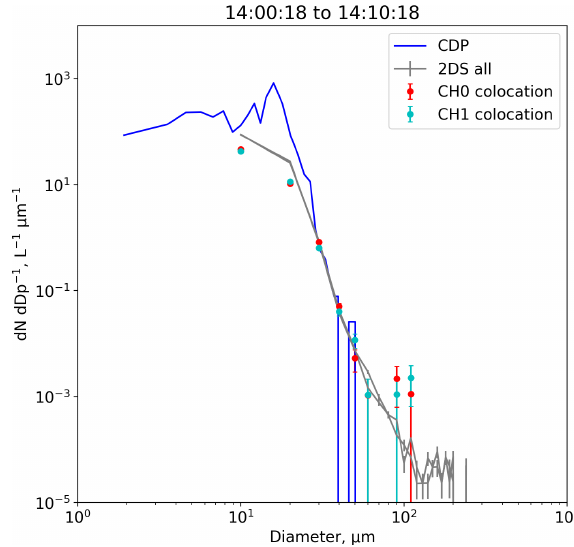
Figure 16. Size distributions from the 2D-S and CDP for different temperatures during a research flight in liquid stratus on 17 Au- gust 2018 at 13 ◦ C. The grey lines show the 2D-S data using con- ventional data-processing protocols without constraining the DoF, while the green and red lines show size distributions for just the co-located particles. CDP size distributions are shown in